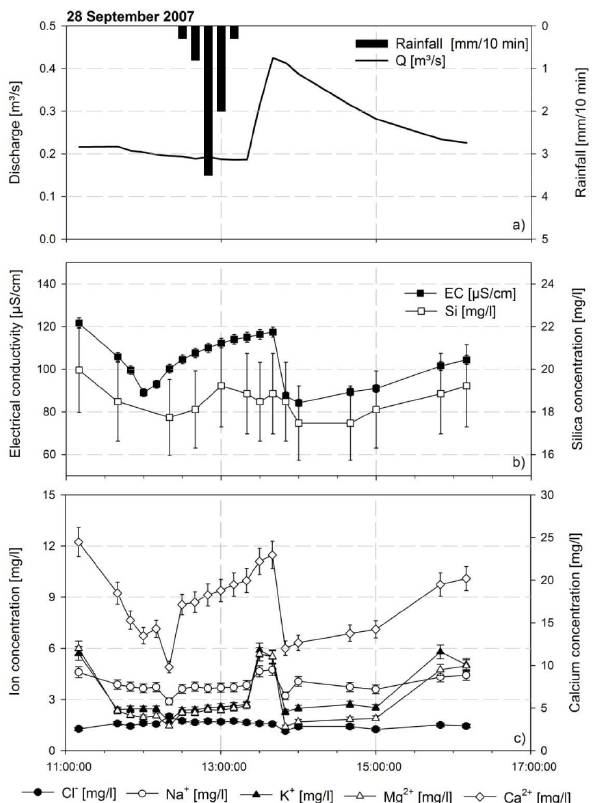
Fig. 3. Event E1 on 28 September 2007: (a) discharge and rainfall, (b) silica and Cl − concentrations, and (c) concentrations of Na + , Mg 2 + , K + , Ca 2 + , and EC values. Error bars indicate measurement uncertainty of 7% for ions and 10% for silica.